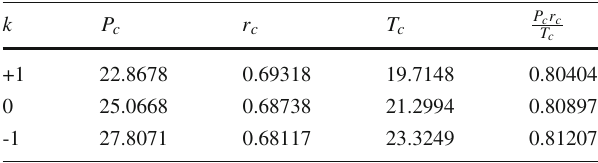
Table 1 Topological black holes: d = 7, q = 1, m = 1, c 0 = c 1